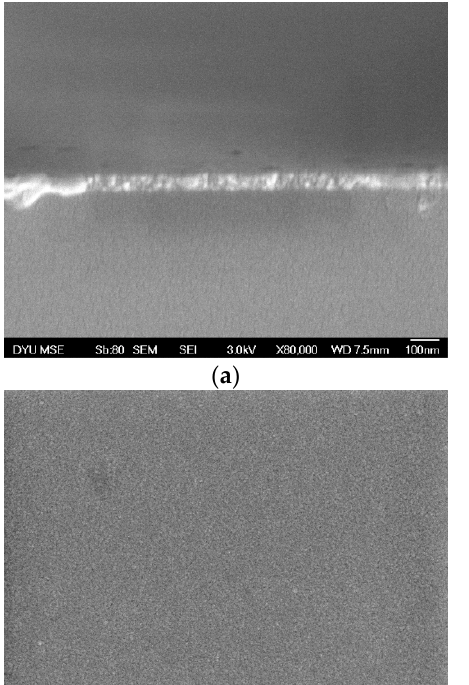
Figure 1. ( a ) FWHM of CoFeW thin films. ( b ) Grain size of CoFeW thin films.